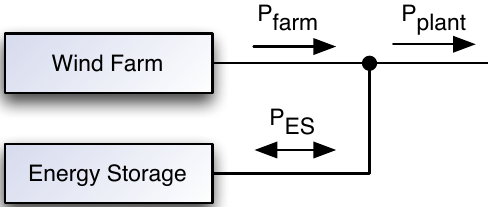
Figure 2. On-site energy storage to provide reserve generation, such that the combined wind farm and energy storage output ( i.e. , P